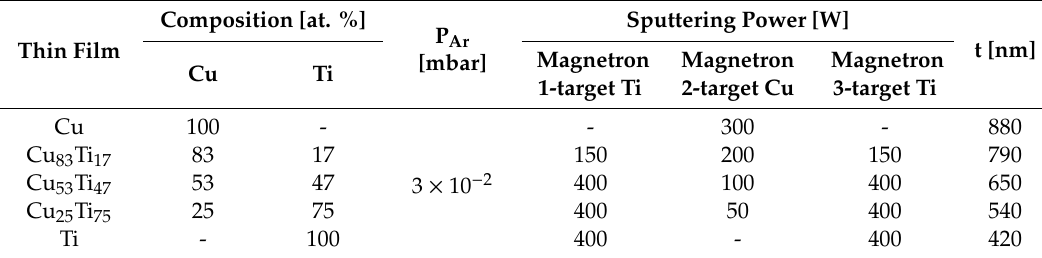
Table 1. Composition and deposition parameters by pulsed DC magnetron sputtering of thin films based on copper and titanium. Composition [at. Thin Film